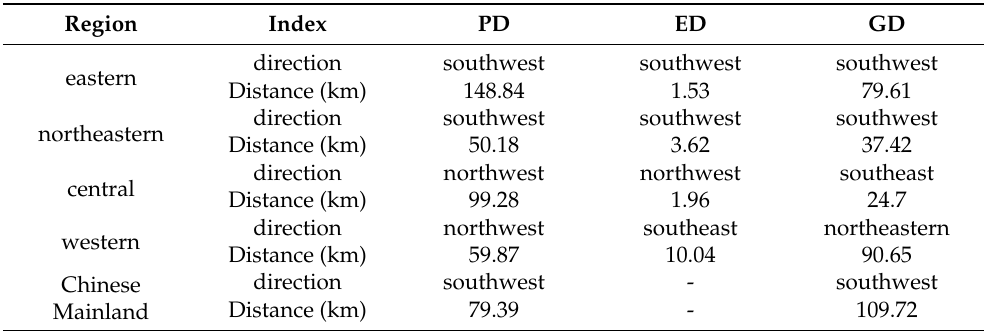
Table 3. Moving direction and distance of gravity center of population density, gross ecosys- tem production density, and gross domestic production density in Chinese Mainland during the investigation